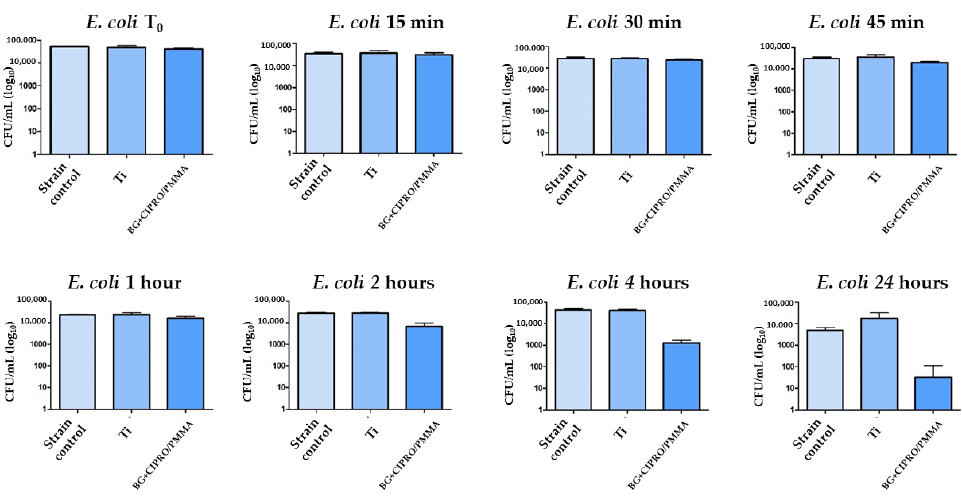
Figure 15. Evaluation of E. coli viability in the presence of bare Ti and BG+CIPRO/PMMA samples .